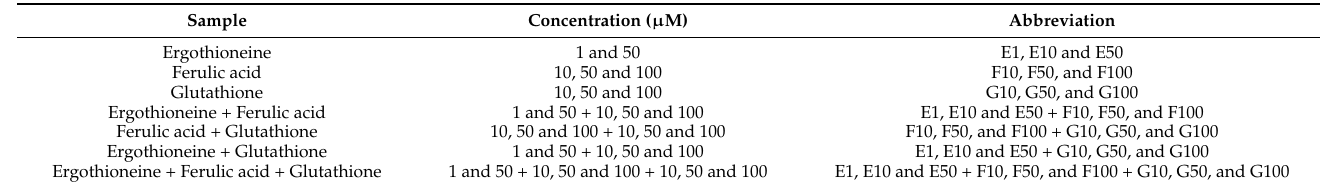
Table 1. List of sample, concentration, and